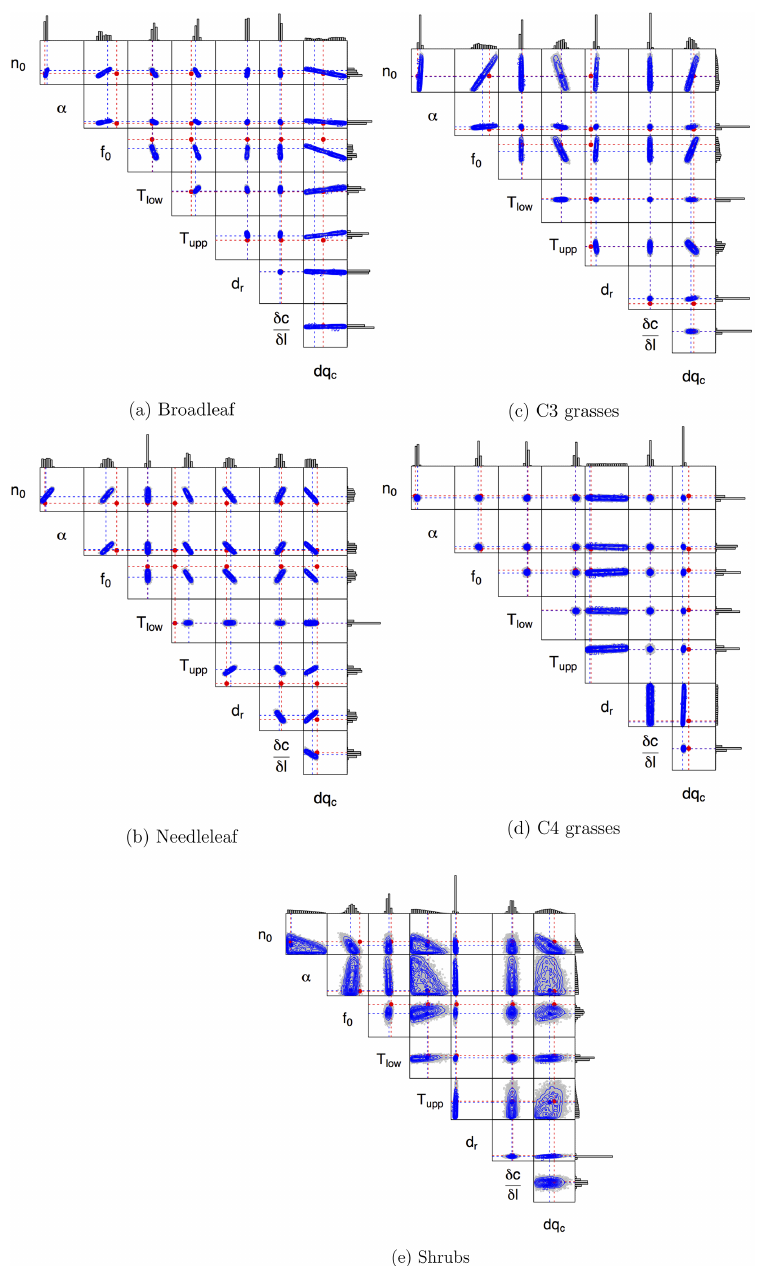
Figure 4. The correlations between parameters for PFT-specific parameter optimisations. Each subfigure shows a 2-D correlation map, within which each box is a 2-D marginal plot. Bar graphs show 1-D marginal distributions for individual parameters. The dimensions of the boxes represent the prior range of each parameter. Red points/dashed lines represent initial parameter values. Blue points/dashed lines represent optimised parameter values. Blue contours illustrate the posterior